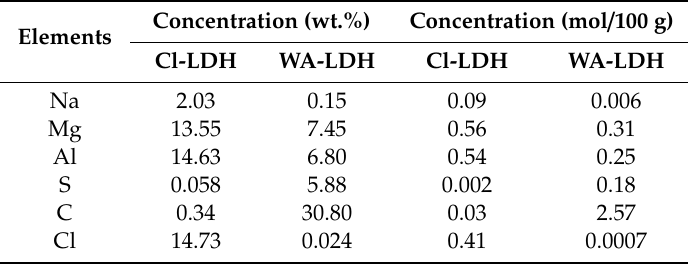
Table 2. Concentration in wt.% and mol / 100 g of the elements of Cl-LDH and WA-LDH determined by XRF and